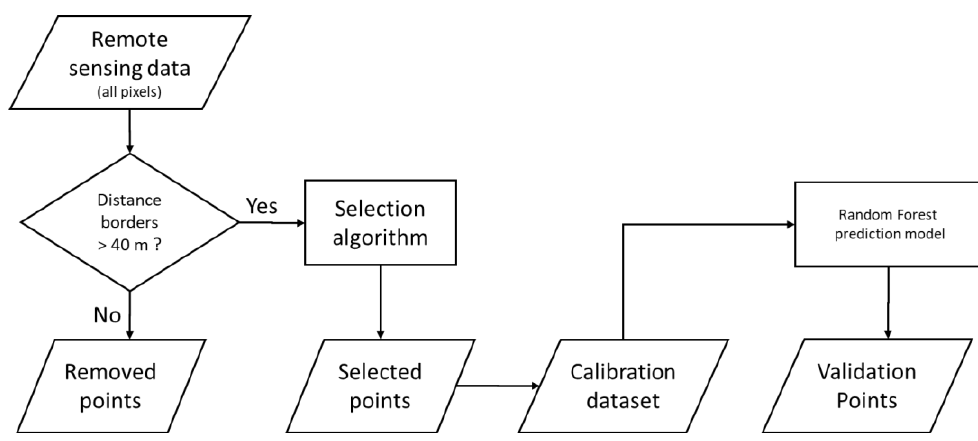
Figure 5. Flow chart concerning sampling strategy and the validation of the prediction models.